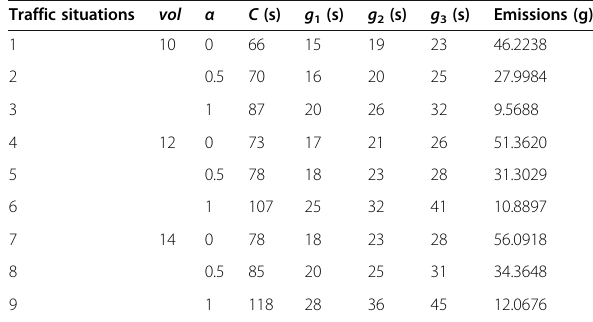
Table 2 Timing results of the intersection in different traffic